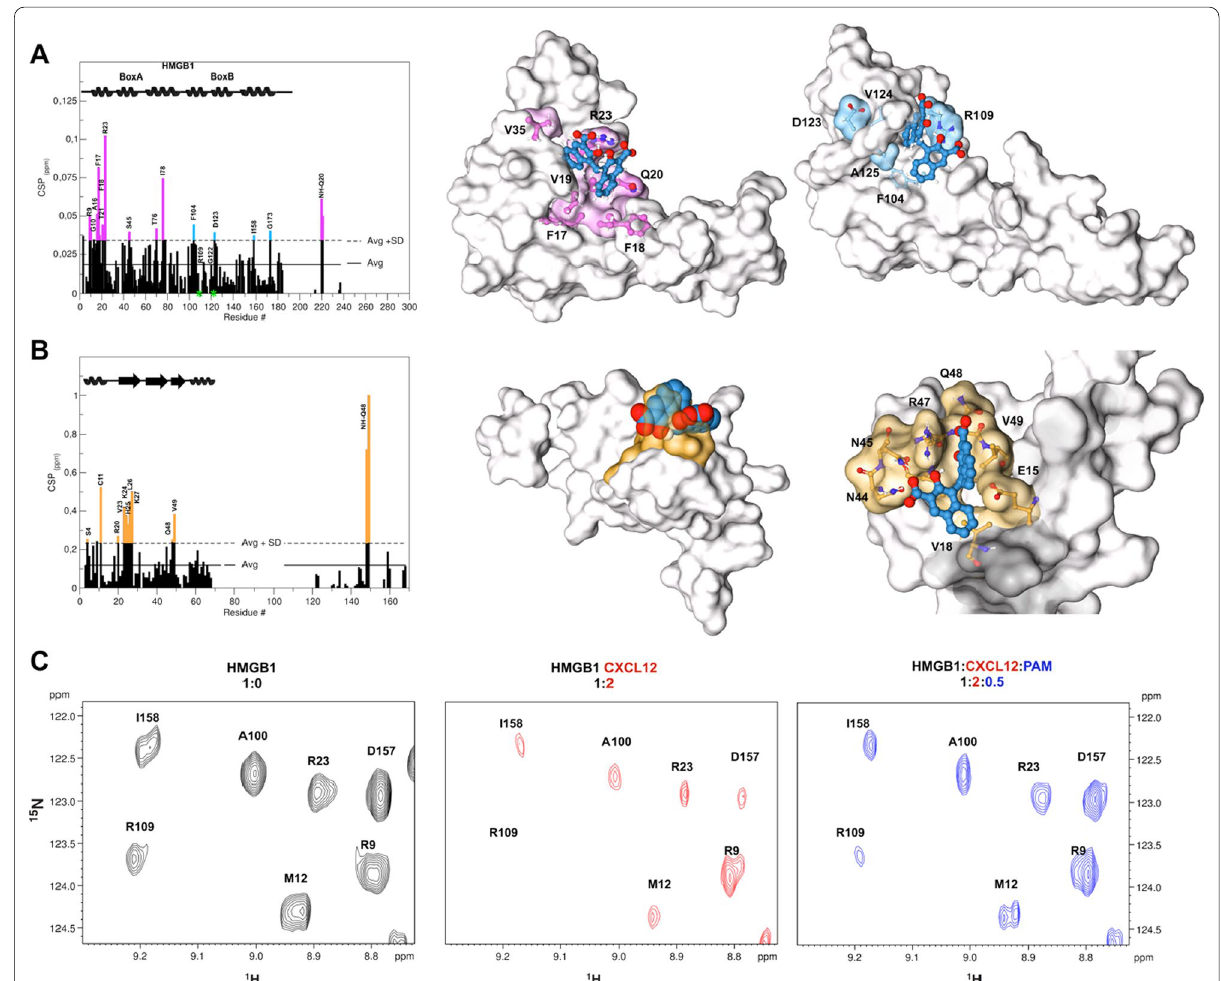
Fig. 1 PAM directly binds to HMGB1 and CXCL12 and disrupts their heterocomplex. A Histogram showing residue-specific CSPs of 15 N-HMGB1 (~ 0.1 mM) upon addition of equimolar ratio of PAM (helices are schematically represented on top). Missing residues are prolines or are absent because of exchange with the solvent. BoxA and BoxB residues with CSP > Avg SD are represented in magenta and light blue, respectively. + HADDOCK models of interaction of PAM (licorice representation) with BoxA (middle) and BoxB (right) (gray surface and colored residues with CSP > Avg SD). HMGB1 residues (sticks) involved in hydrophobic and electrostatic interactions with PAM are labeled. B Histogram showing the + CSPs of 15 N-CXCL12 amides (~ 0.1 mM) upon addition of equimolar ratio of PAM. Missing residues are prolines. Elements of secondary structure are represented on top. Middle: HADDOCK model of interaction of PAM (CPK representation) with CXCL12 (gray surface). CXCL12 residues with CSP > Avg SD located around the sY21 binding site are in orange. Right: Zoom in the binding site, CXCL12 residues (sticks) involved in + hydrophobic and electrostatic interactions with PAM (sticks) are explicitly labeled. C Selected region of 1 H- 15 N HSQC HMGB1 (0.1 mM) spectrum without (black, left), with 0.2 mM CXCL12 (red, middle) and upon addition of 0.05 mM PAM (blue,